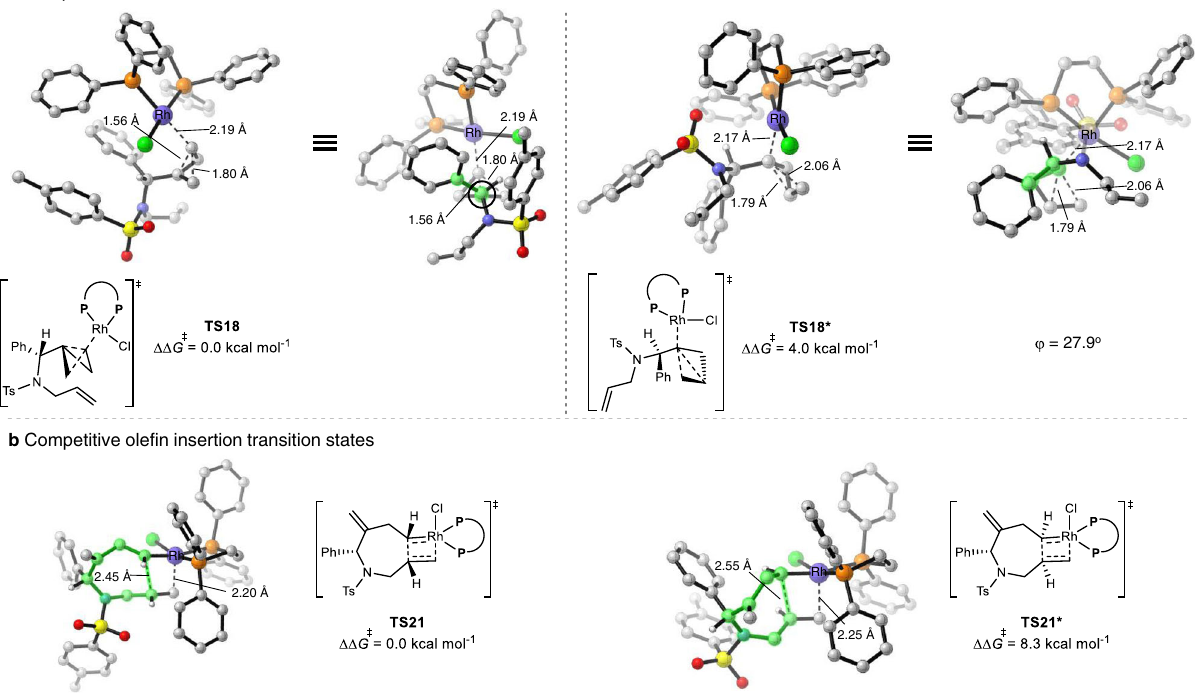
Fig. 8 | DFT analysis of the origins of regio- and diastereoselectivity for Rh(I)/ dppe-catalyzed cycloisomerizations. DFT-optimized structures of a rhodium carbenoid formation and b ole fi n insertion transition states involved in